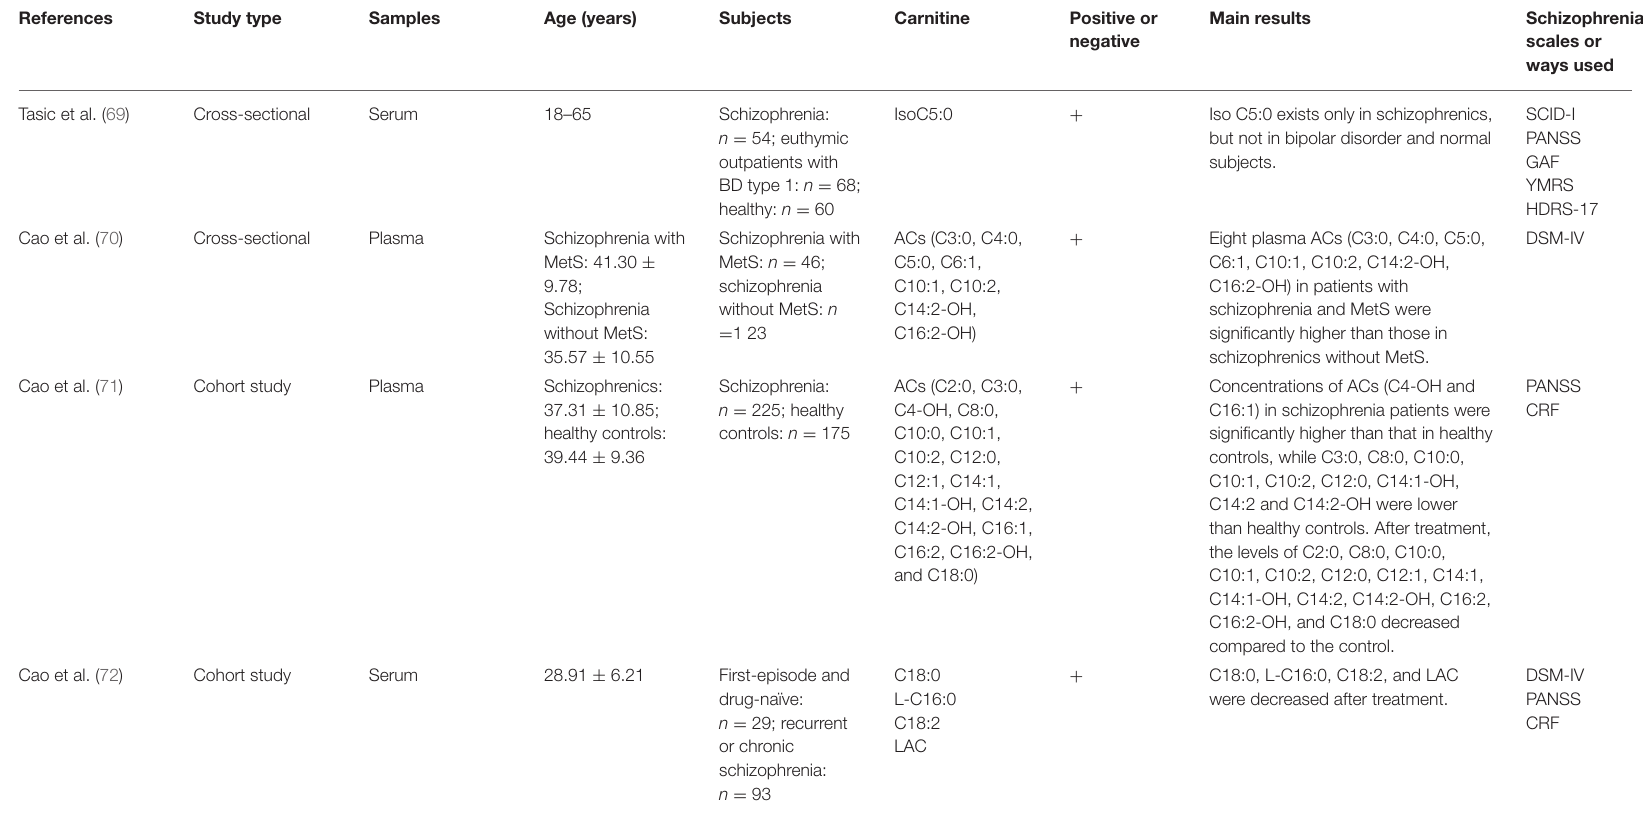
TABLE 4 | Main information of clinical researches studying the correlation between carnitine level and